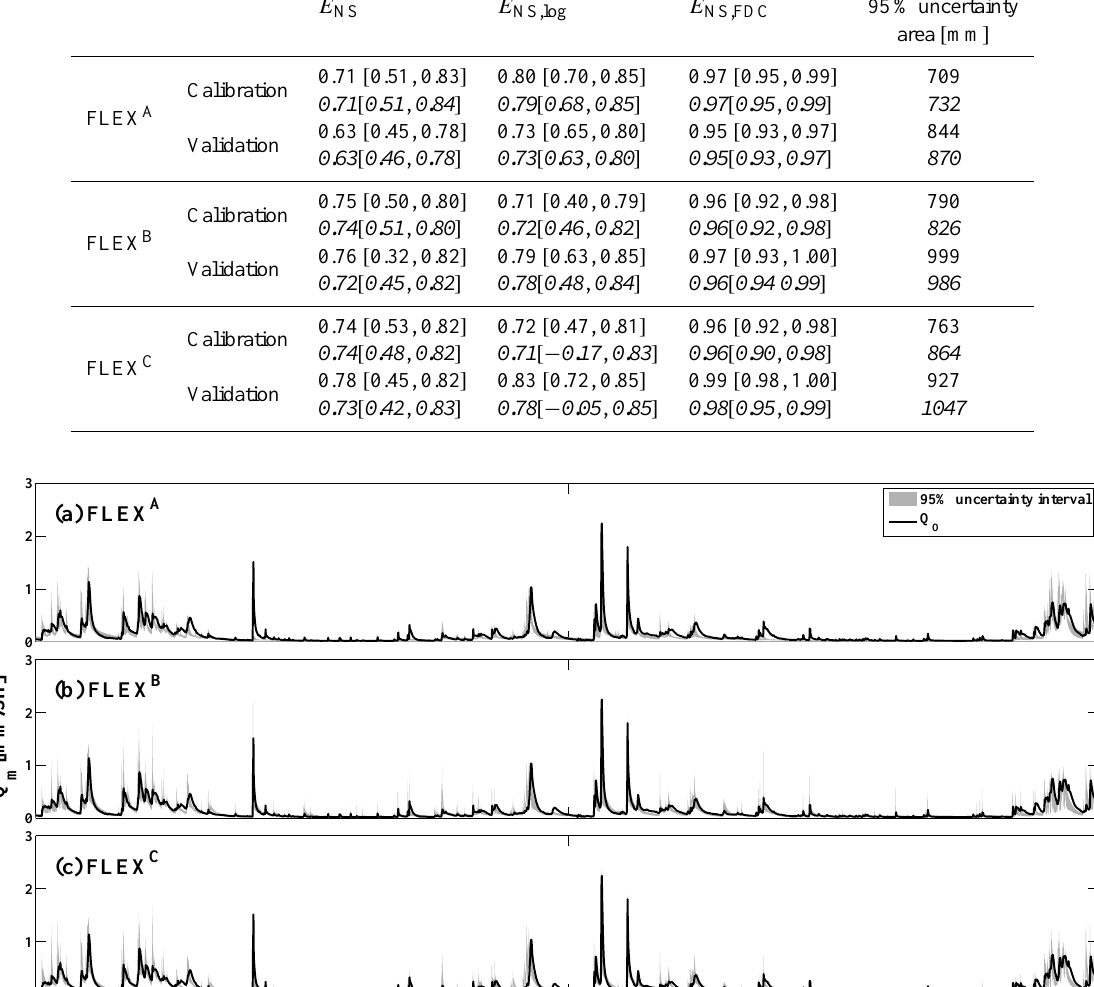
Table 5. The median model performances (in brackets their corresponding Pareto uncertainty intervals) and the area spanned by the uncer- tainty interval of the hydrograph derived from the Pareto optimal solutions of the constrained and calibrated model setups FLEX A , FLEX B and FLEX C for the three modeling objectives ( E NS , E NS,log , E NS,FDC ) in the calibration (2002–2005) and validation (2006–2009) periods. The italic values indicate performance and 95% uncertainty interval of hydrograph for the benchmark models (without any constraints).